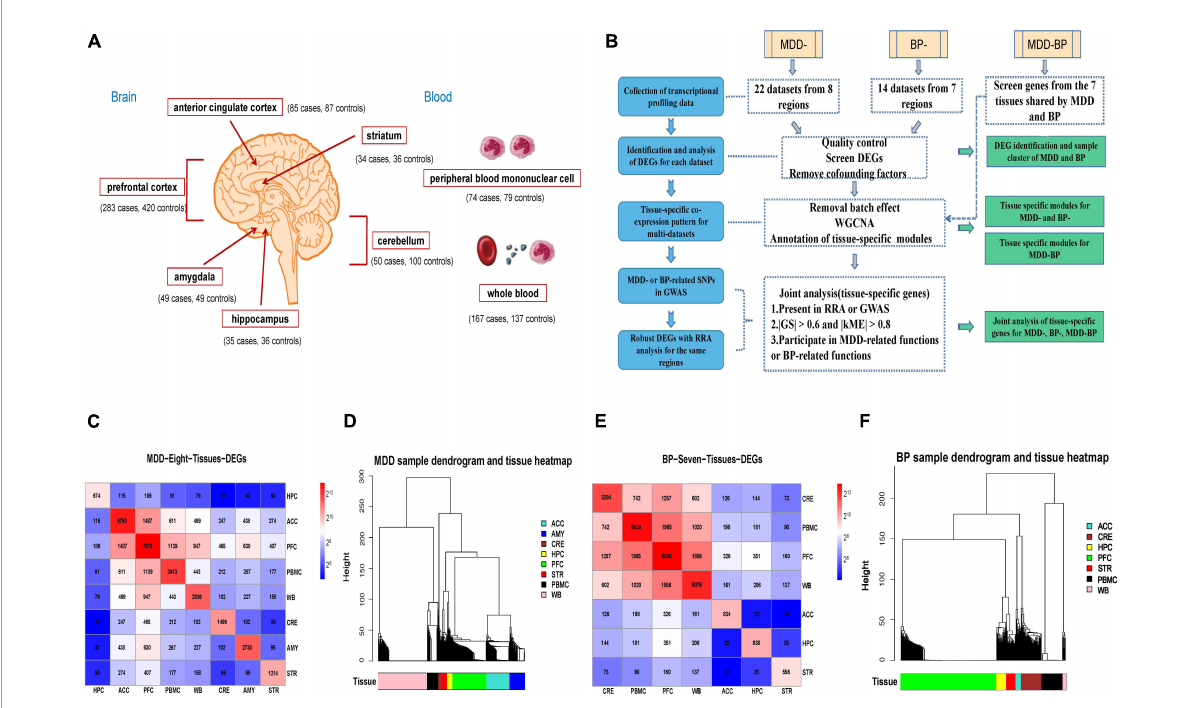
FIGURE1 (A) Schematic diagram of tissue source and sample quantity. (B) Technology roadmap. (C,D) Are intersections of the tissues and data were transformed using Log2 as well as hierarchical clustering between different tissue samples in MDD. (E,F) Are intersections of the tissues and data were transformed using Log2 as well as hierarchical clustering between different tissue samples in